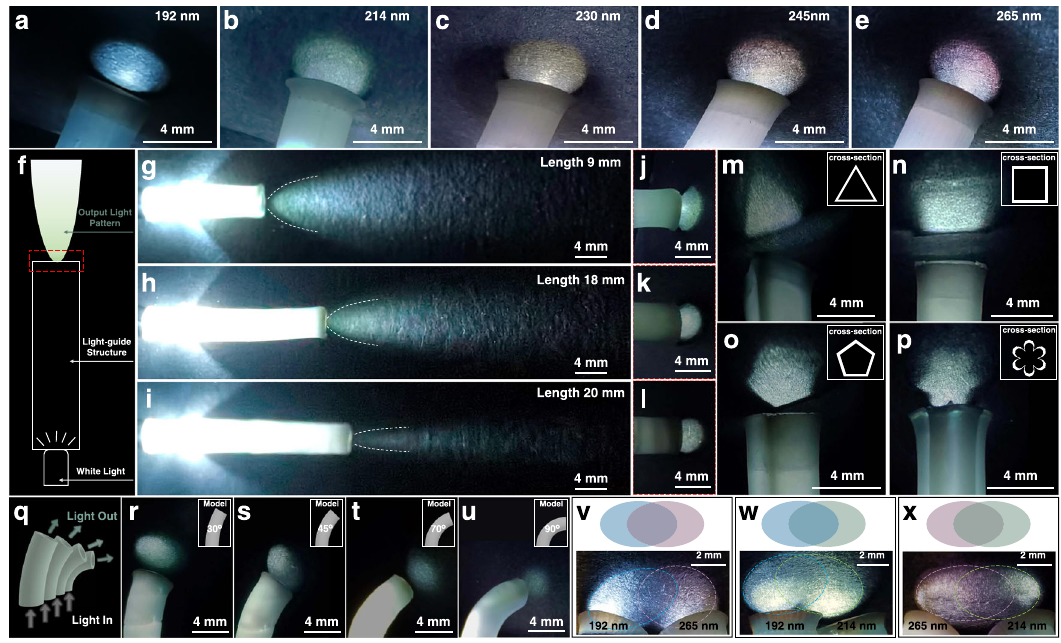
Fig.5|ContinuousDLP3DprintedPCsstructuresascolorandpatternselective optical light-guide tubes. a – e Optical images of hollow cylinder-shaped tubes with different frequency selective light-guide property printed from PS particles with diameters of 192nm ( a ), 214nm ( b ), 230nm ( c ), 245nm ( d ), and 265nm ( e ), respectively. f Schematic illustration of the length-dependent optical loss char- acterization. g – l Optical images of light-guide performance of hollow cylinder- shapedtubeswithlengthsof9mm( g,j ),18mm( h , k )and20mm( i,l ),respectively. j – l are the optical images of output light morphology on a blackbackground from different lengths. m – p Optical images of output light patterns with triangle ( m ),